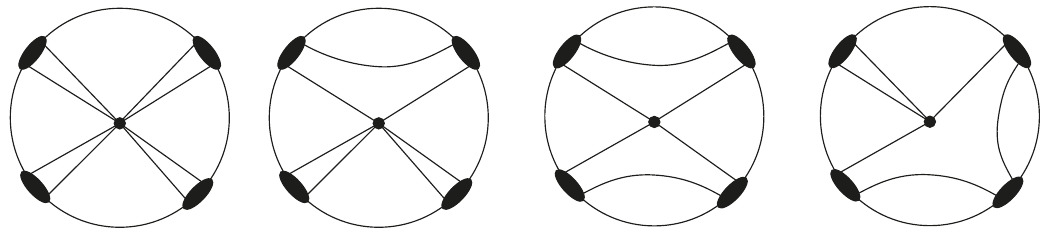
Figure 5 . Tree level diagrams contributing to the 4-pt function hO 2 O 2 O 2 O 2 i from φ 8 , φ 6 and φ 4 interactions. Additional diagrams obtained by permuting the external operators must be